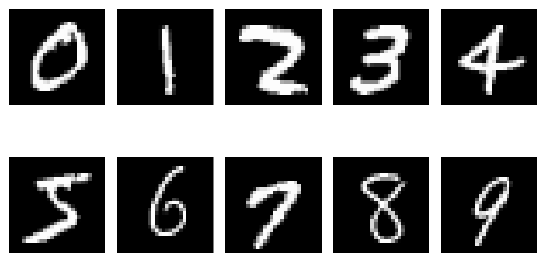
Figure 5. Example of MNIST